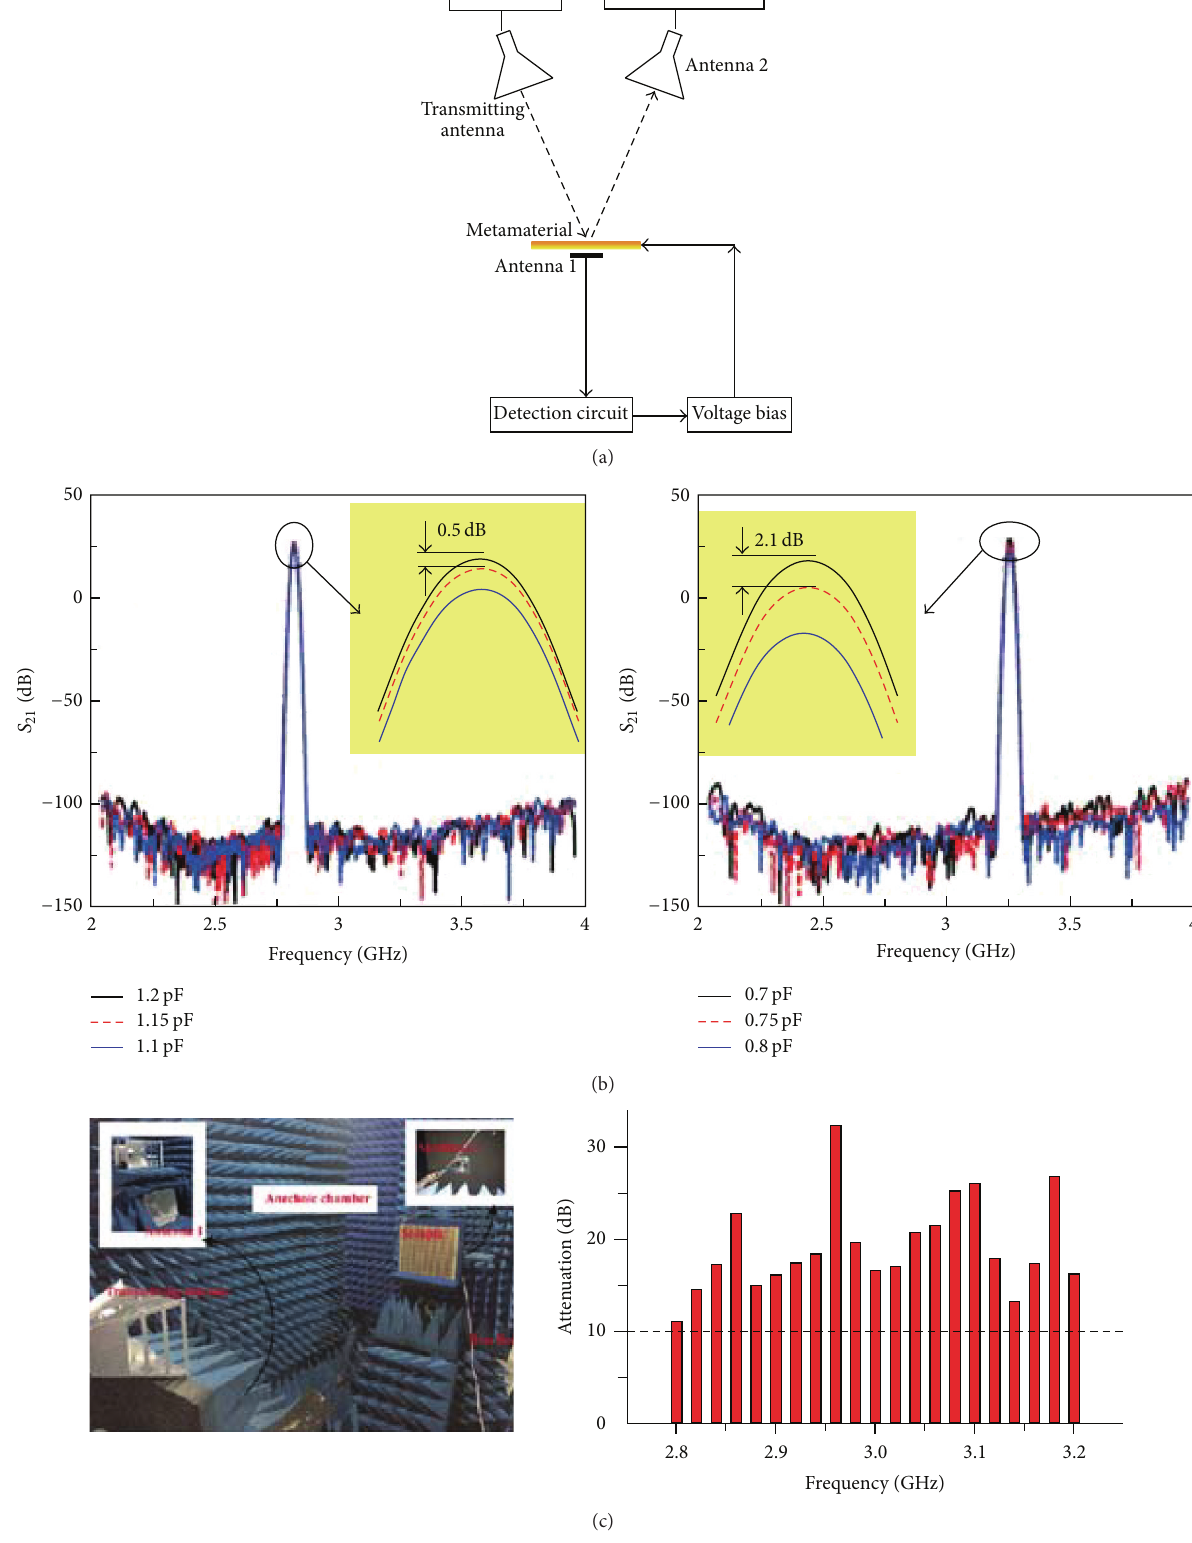
Figure 46: Self-tuning smart absorber. (a) Schematic of the operational principle. (b) Transmission coefficient of the absorber for a narrow incident wave for various capacitances at 2.75 GHz (left panel) and 3.25 GHz (right panel). (c) Experimental setup (left panel) and measured attenuation of the reflection wave when the incident wave is swept from 2.8 to 3.2 GHz (right